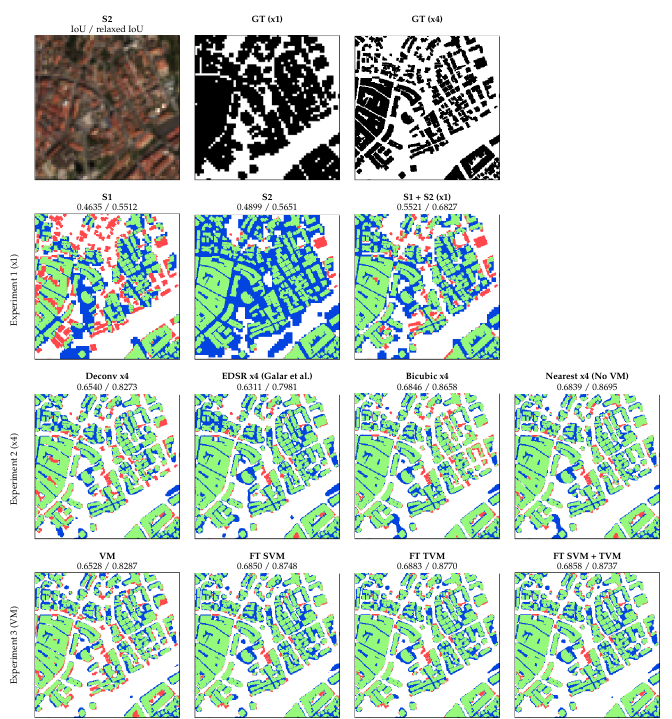
Figure6. Visualcomparisonoftheresultsobtainedwithallthemodelsincludedintheexperiments,fortwozonestakenfromthetest Figure 6. Visual comparison of the results obtained with all the models included in the experiments, set.TParepresentedingreen,FPinblue,FNinredandTNinwhite. for two zones taken from the test set. TP are presented in green, FP in blue, FN in red, and TN completemapisavailableatourwebpage 1 . Inthenearfuturethemapwillbeupdated 610 includingabuildingfootprintlayer. 611 in white. VersionAugust1,2021submittedto RemoteSens.